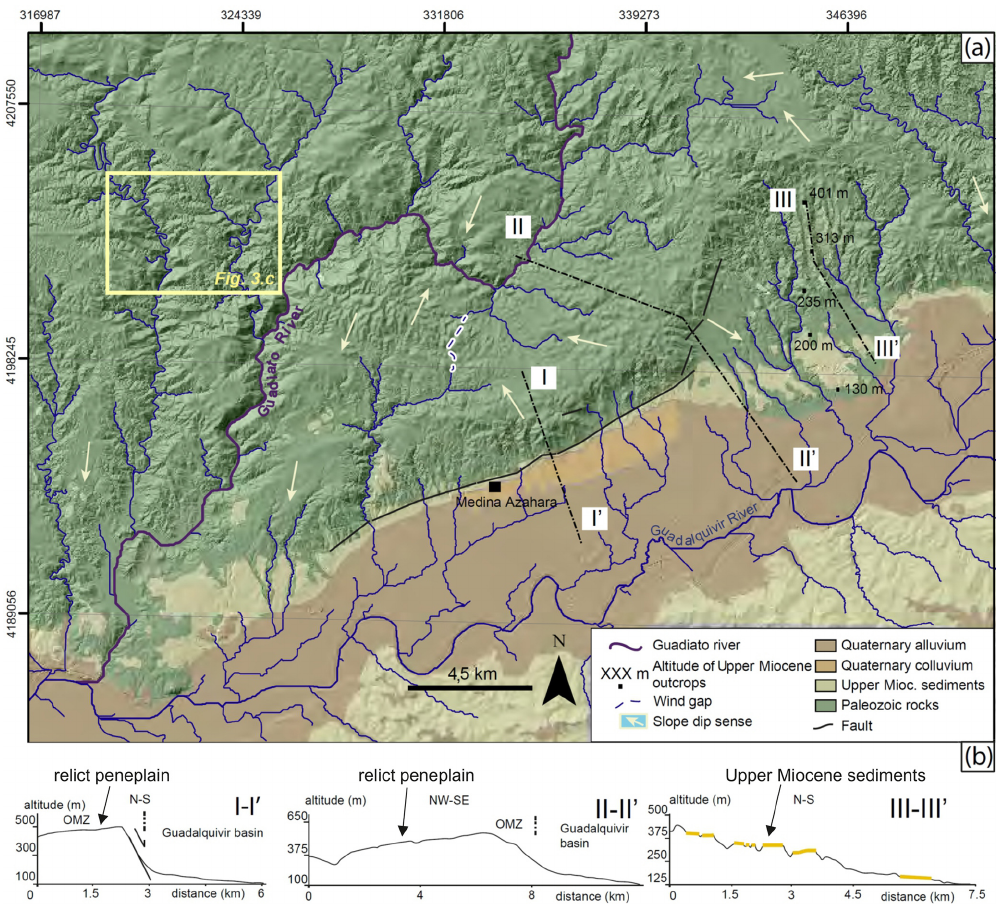
Figure 4. (a) Simplified geological/hillshade relief map of the Guadiato river area (S6), with the location given in Fig. 1b. (b) Topographic profiles across the Iberian Massif/Guadalquivir basin boundary. The altitude base and reference system are as in Fig. 1.